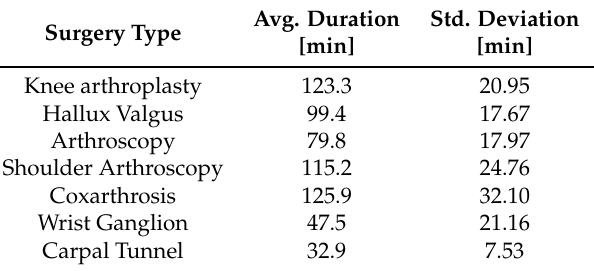
Figure 3. Occurrence of surgeries. The occurrence of some types of surgery that can be performed in the OSD of the LBH are shown. Table 3. Duration of the surgeries performed in the OSD of the